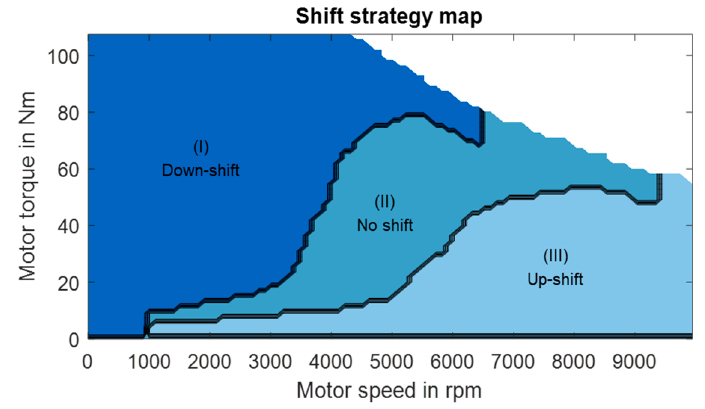
Figure 6. Shift strategy map.